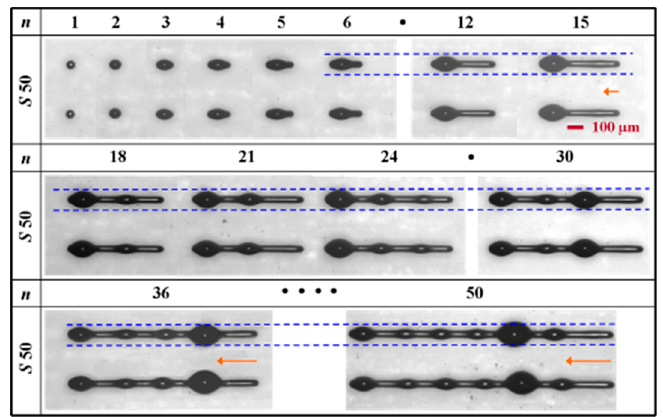
Figure 8. Microscopic images of inkjet-printed lines with 40% droplet overlap on S 50 substrate for different numbers of droplets ( n ) at room temperature.